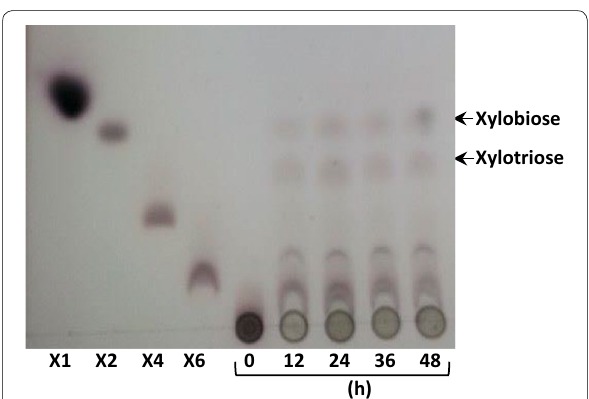
Fig. 6 TLC analysis of Beechwood xylan by Lr XynA trough kinetic time of 0, 12, 24, 36 and 48 h. Standards: X1 (xylose), X2 (xylobiose), X4 (xylotetrahose) and X6